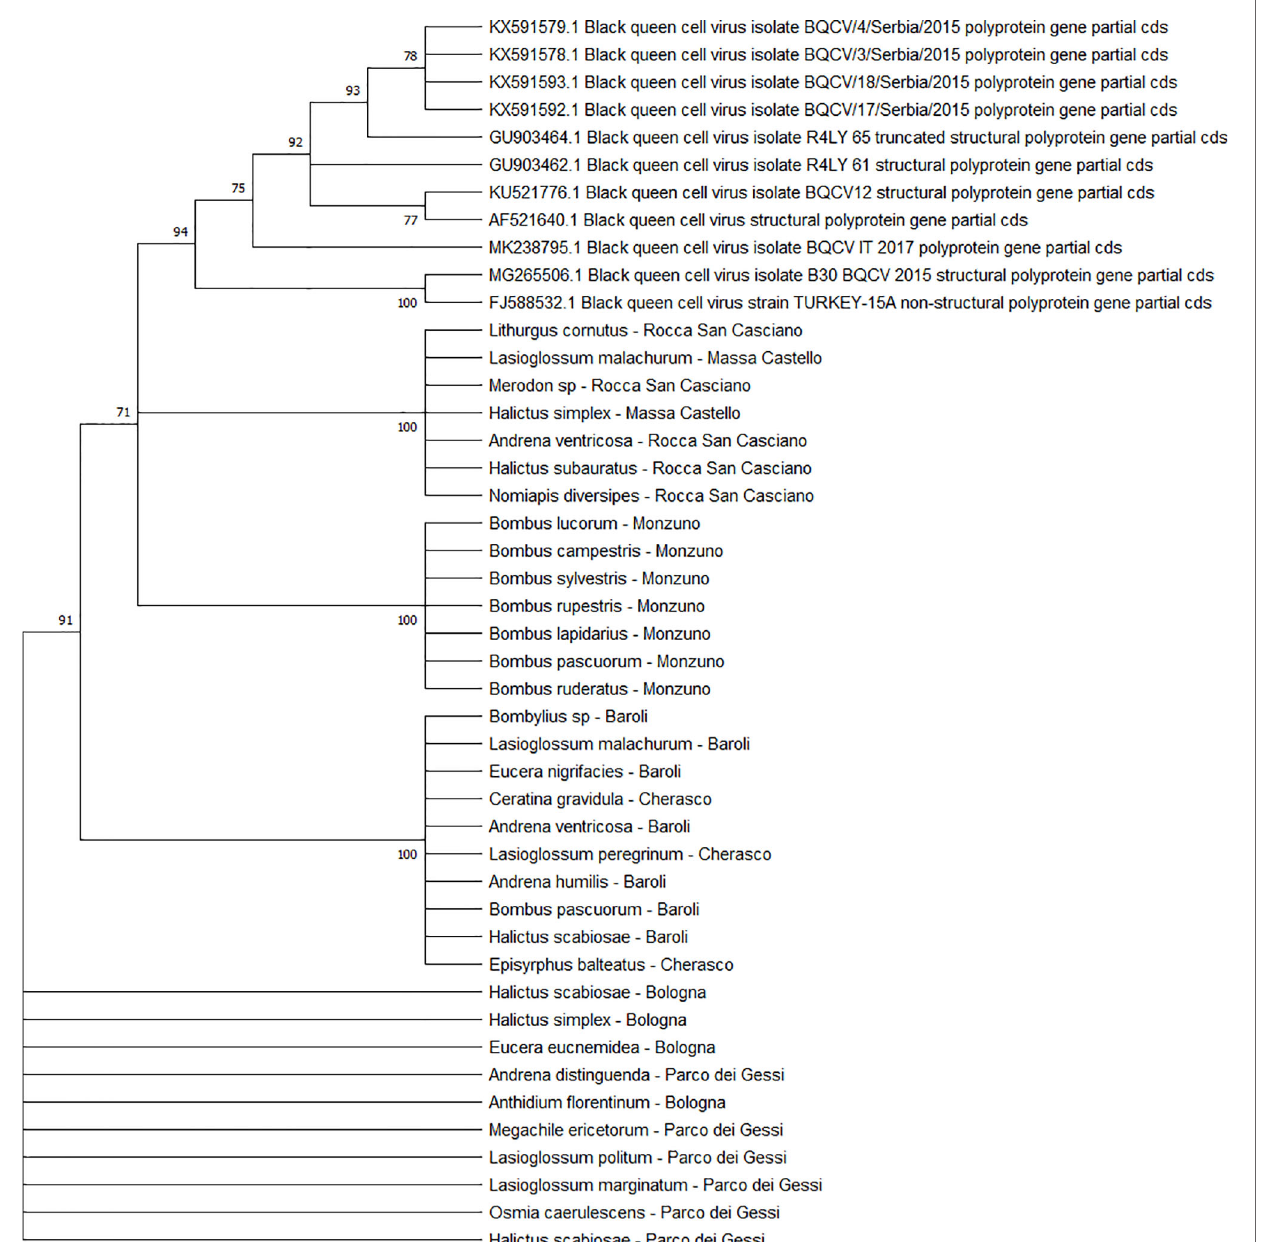
FIGURE 10 | Maximum likelihood nucleotide phylogeny of BQCV polyprotein gene. This analysis involved 45 nucleotide sequences. There were a total of 701 positions in the fi nal dataset. Only those with bootstrap > 50% are reported. Species and sampling sites are reported for the sequences identi fi ed in this study. BQCV, black queen cell